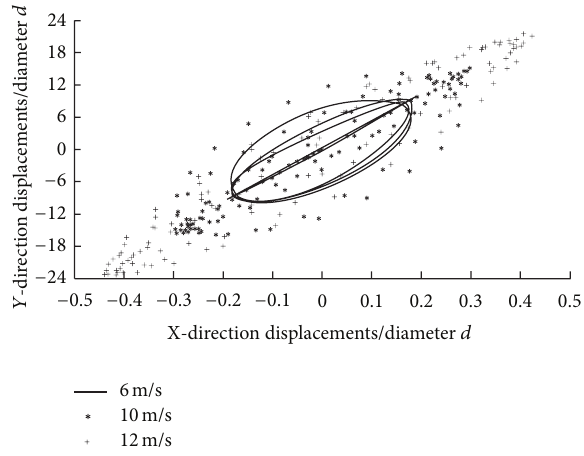
Figure 9: Leeward conductor displacements with the elliptical orbits.